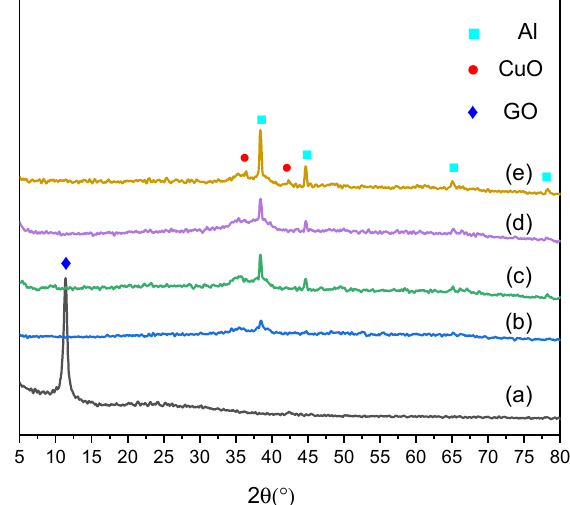
Figure 1. XRD patterns of Al–CuO/GO nanocomposites: ( a ) GO, ( b ) CuO:Al = 2.5:1, ( c ) CuO:Al = 2:1, ( d ) CuO:Al = 1.5:1, and ( e ) CuO:Al = 1:1.